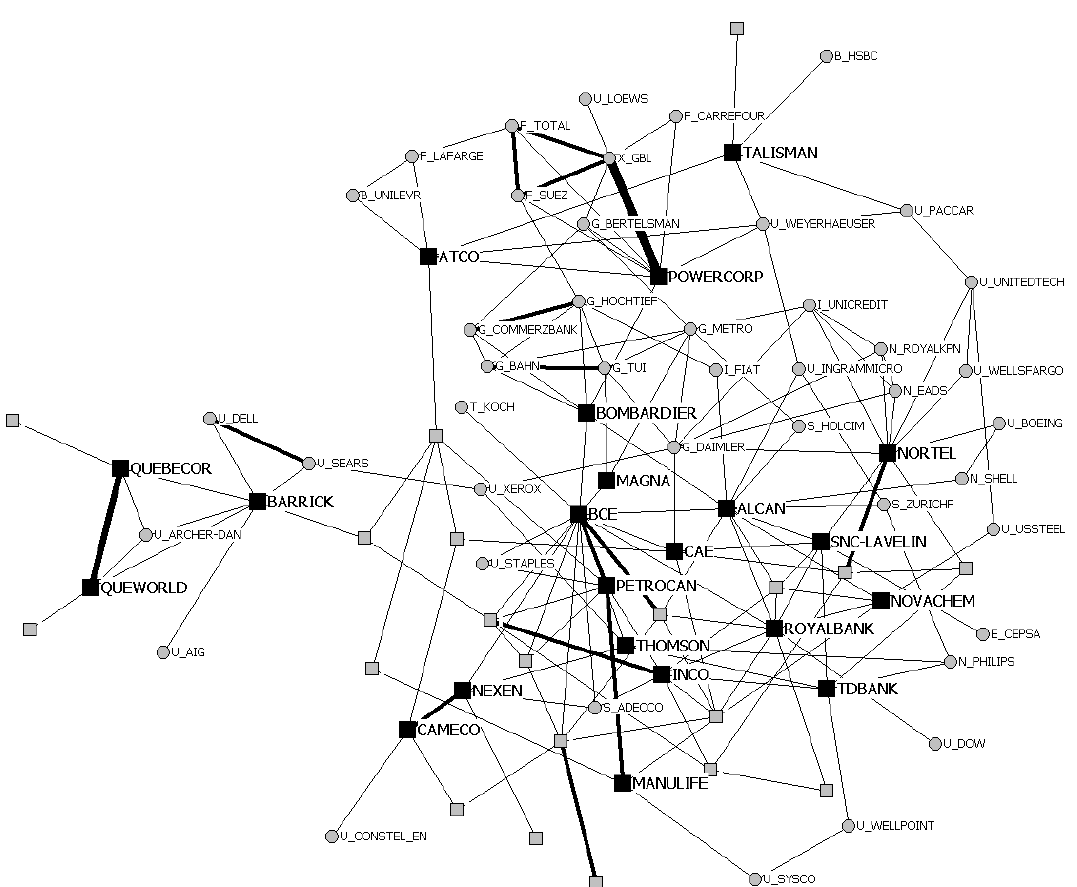
Figure 6. Interlocks among Canandian TNCs and non-Canadian G500 firms, 2006